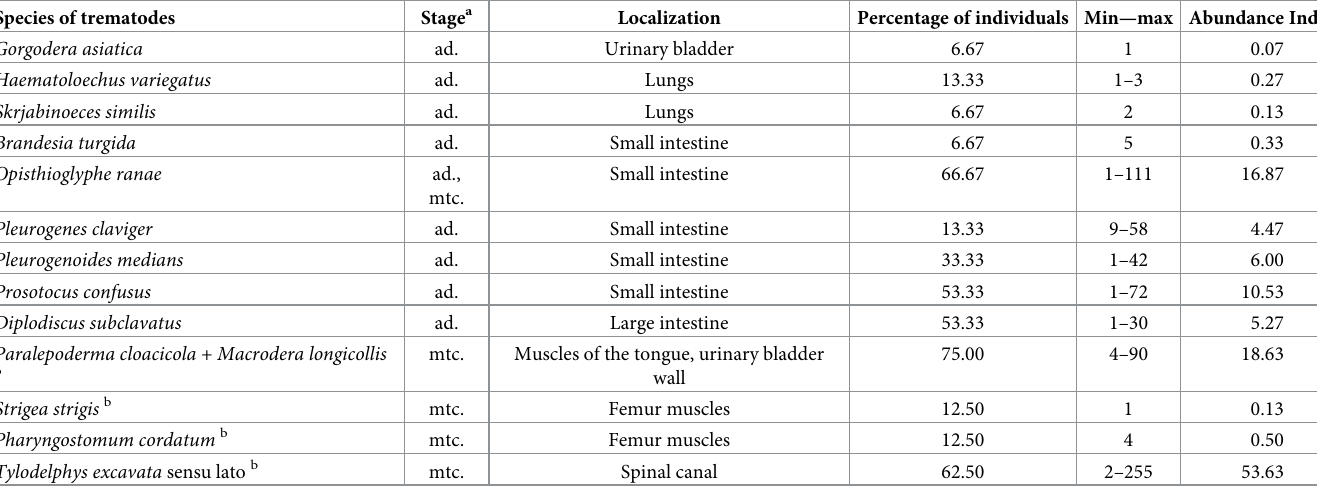
Table 6. Trematodes (adult worms and metacercariae) from the individuals ( n = 15) of the marsh frog ( Pelophylax ridibundus ) from waterbodies examined.